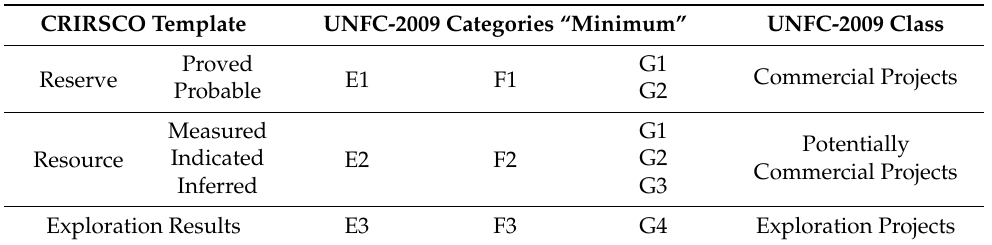
Table 2. Mapping of CRIRSCO template to United Nations Framework Classification (UNFC)-2009 Classes and Categories (modified from UNECE 2013